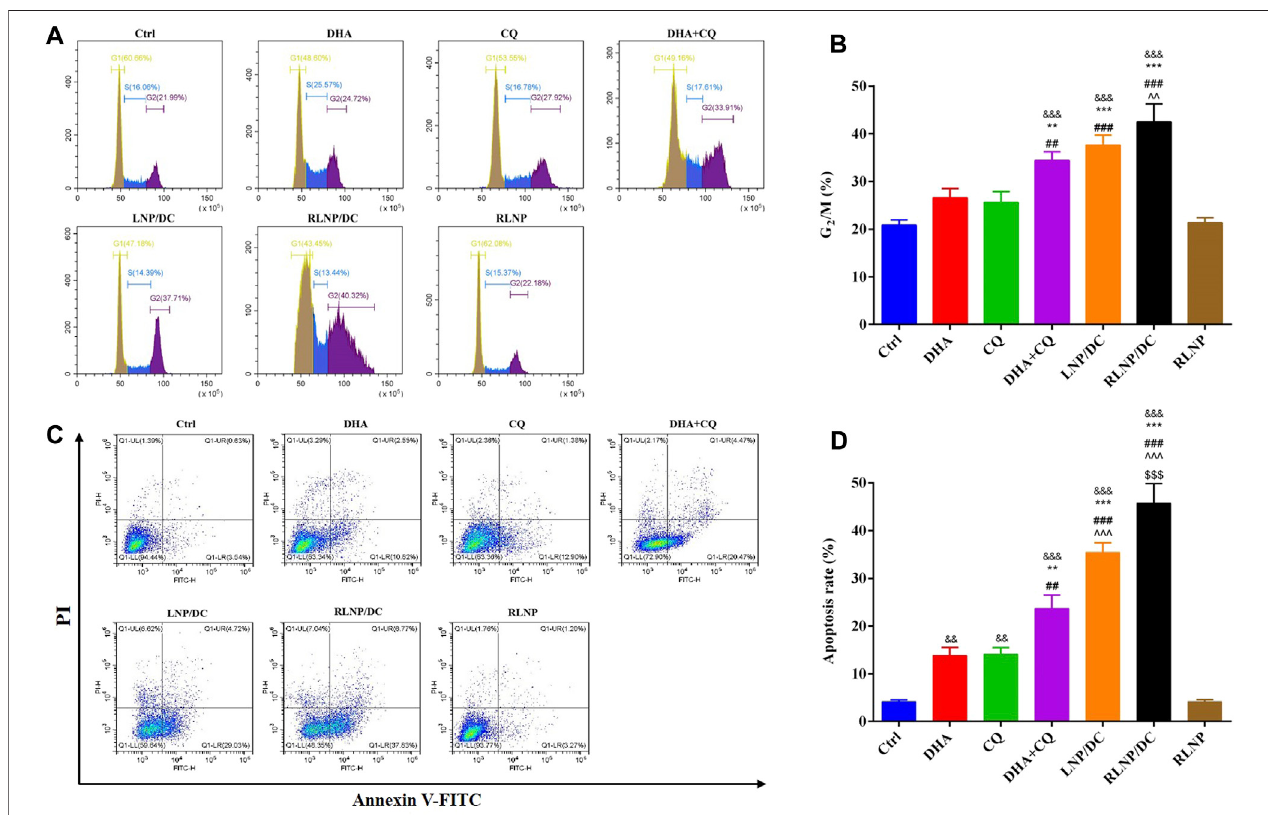
FIGURE5| Analysisofcell-cyclearrest (A,B) andapoptosisrate (C,D) assayinHCT116cellsafter24 hoftreatmentbyDHA,CQ,DHA+CQ,LNP/DC,RLNP/DC, and RLNP. Each bar represents the mean ± SD ( n (cid:1) 3). && p < 0.01 and &&& p < 0.001 vs. Ctrl; ** p < 0.01 and *** p < 0.001 vs. DHA; ## p < 0.01 and ### p < 0.001 vs. CQ; ^^^ p < 0.01 and ^^^^ p < 0.001 vs. DHA + CQ; $$$ p < 0.001 vs.